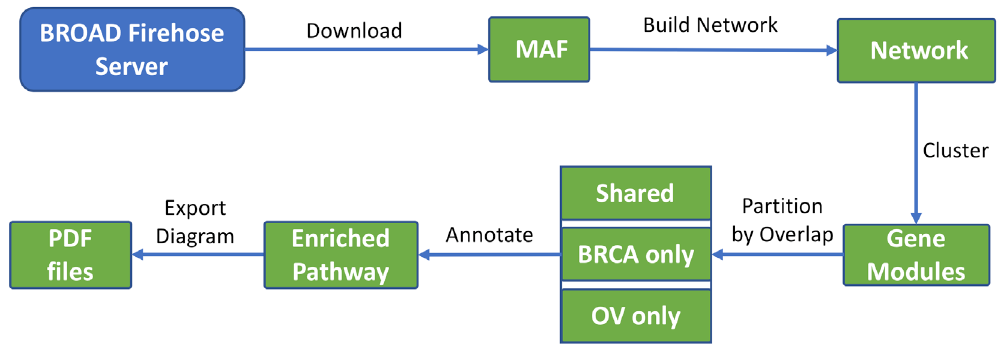
Figure 2. The workflow of the comparison analysis use case using TCGA OV and BRCA mutation data.